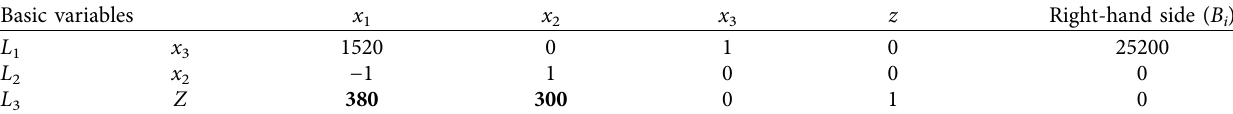
Table 4: The canonical form of problem (P).